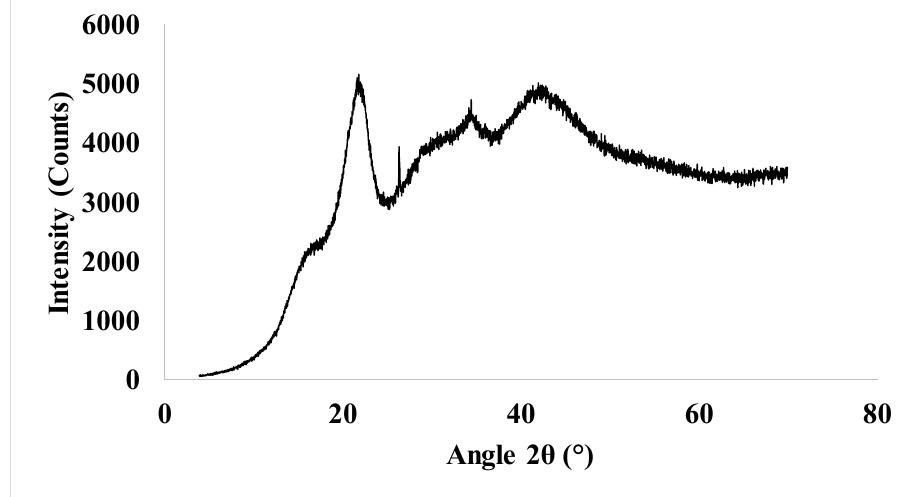
Figure 5. XRD pattern of sugarcane bagasse.